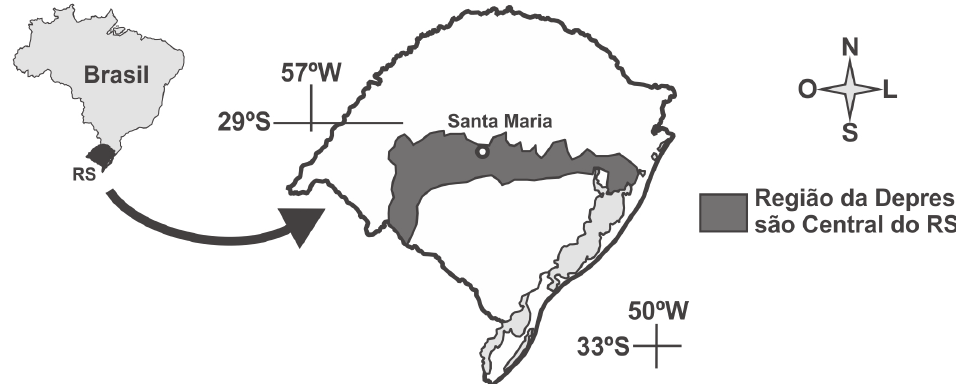
figura 1. localização da região de coleta dos perfis de